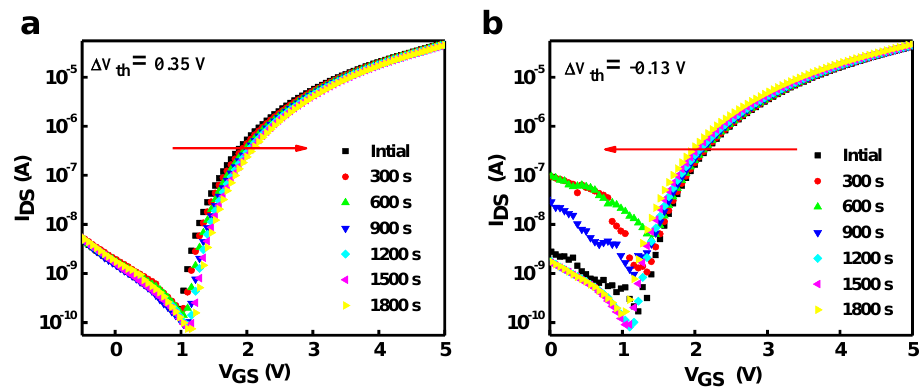
Figure 8. ( a – c ) Transfer characteristics of the In 2 O 3 /HfO 2 TFTs. ( d – f ) Output characteristics of the In 2 O 3 /HfO 2 TFTs.